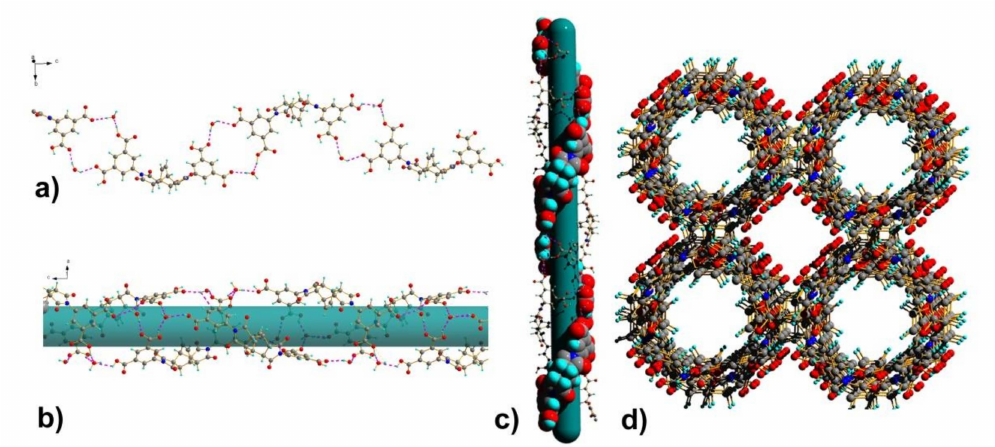
Figure 4. The mono-helix H-bond chain layer ( a ); the bi-helix chains interacted chiral H-bond tube ( b , c ); the packing of the hydrogen bonded tubes ( d ) in 1-H